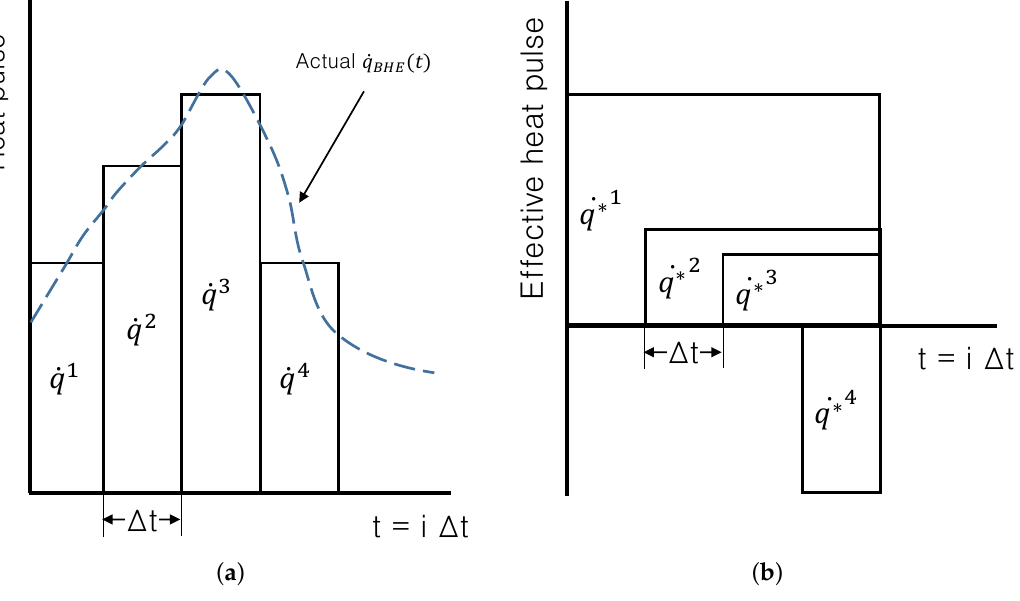
Figure 13. Superposition of piecewise heat steps. The actual pulses ˙ q 1 , ˙ q 2 , ˙ q 3 , ˙ q 4 are superimposed in time as “effective pulses” ˙ q ∗